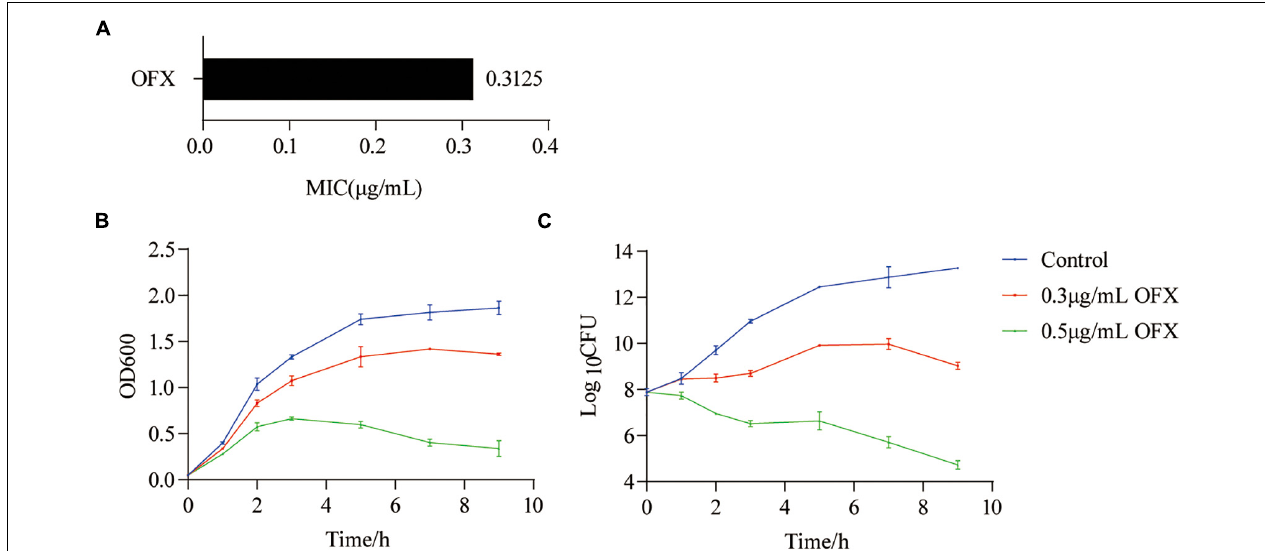
FIGURE 1 | Killing curves of ofloxacin on V. alginolyticus . (A) MIC of V. alginolyticus. (B) Growth curve of V. alginolyticus in medium with the indicated concentrations of OFX. (C) CFU of (A) . Each data point represents means ± standard errors of the means (SEM) from three replicates.